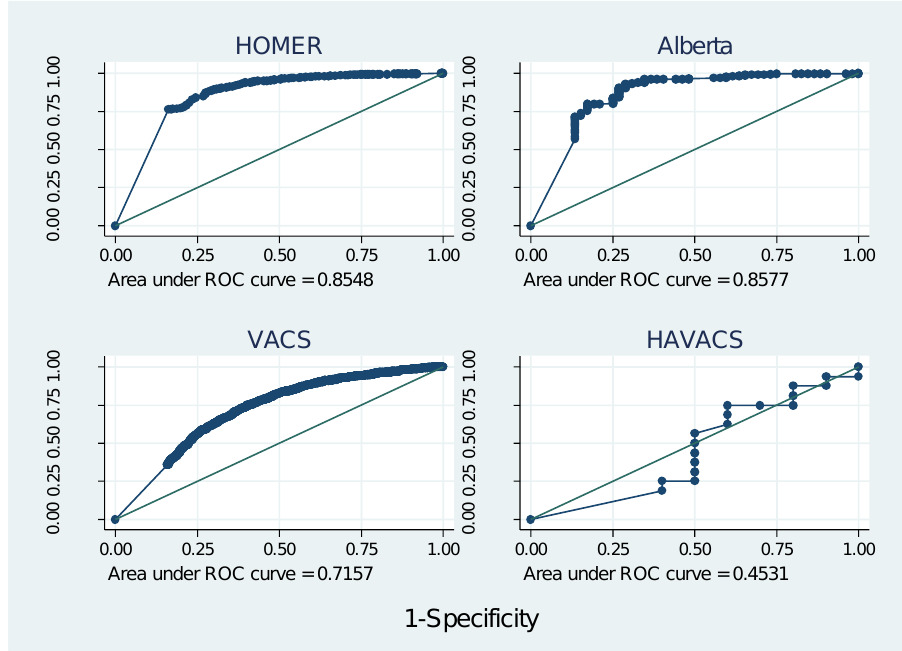
Figure 3. Receiver operating characteristic (ROC) curves for cohorts with pharmacy data.